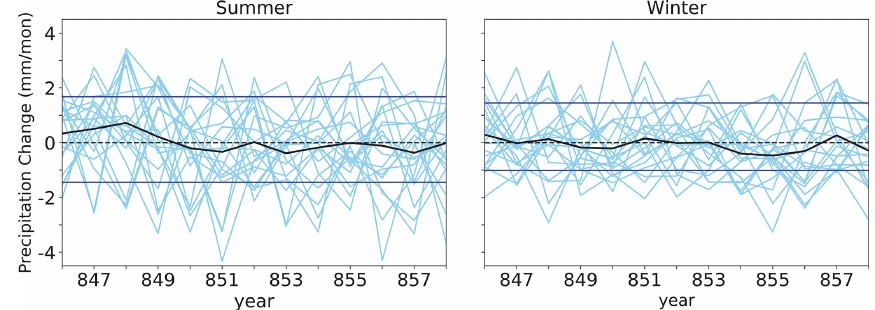
Figure H1. The spatially averaged NH extratropical (15–90 ◦ N latitudes) precipitation anomalies from 20 ensemble simulations for summer (JJA) and winter (DJF) in light blue lines. The thick black lines indicate the ensemble means and the horizontal blue lines represent 1 standard deviation from the ensemble means of the 845–852CE pre-eruption period.